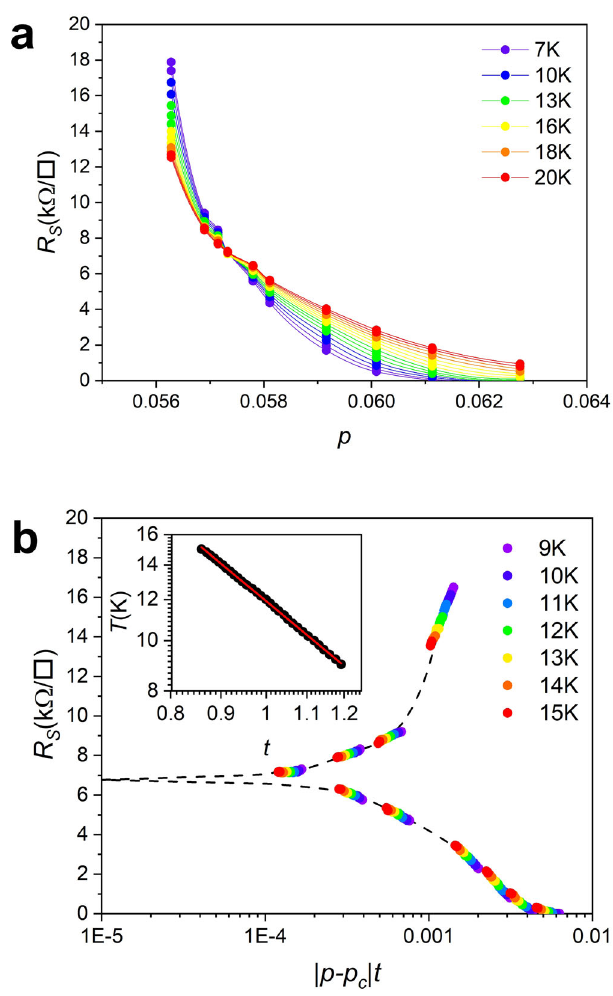
Fig. 4 Finite-size scaling of QPT. a Doping dependence of isothermal sheet resistance from 7 to 20 K. The dots are extracted from R S ( T ) data and the lines are splined guides for the eye. b Universal fi nite-size scaling function at the SIT with t = T − 1/ ν z . Inset: The linear relation between T and t and between 9 and 15 K when the data is plotted on a log-log scale. From the slope we obtain the critical exponent product ν z = 1.57 ±